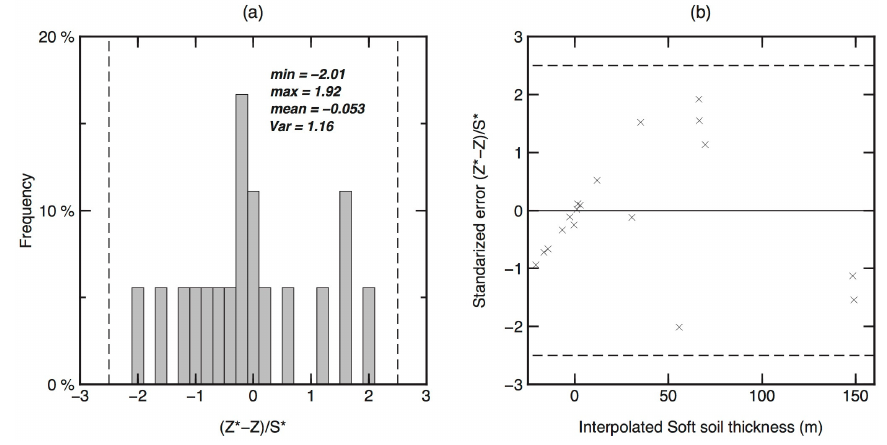
Figure 6. ( a ) Map of compressible soil thickness from this study (Box B in Figure 1a). ( b ) Compressible soil thickness map from [28]. Circles indicate the location of the 18 boreholes where the thickness of the compressible deposit was measured. Map of residuals between maps ( a , b ) is shown in Supplementary Figure A2.